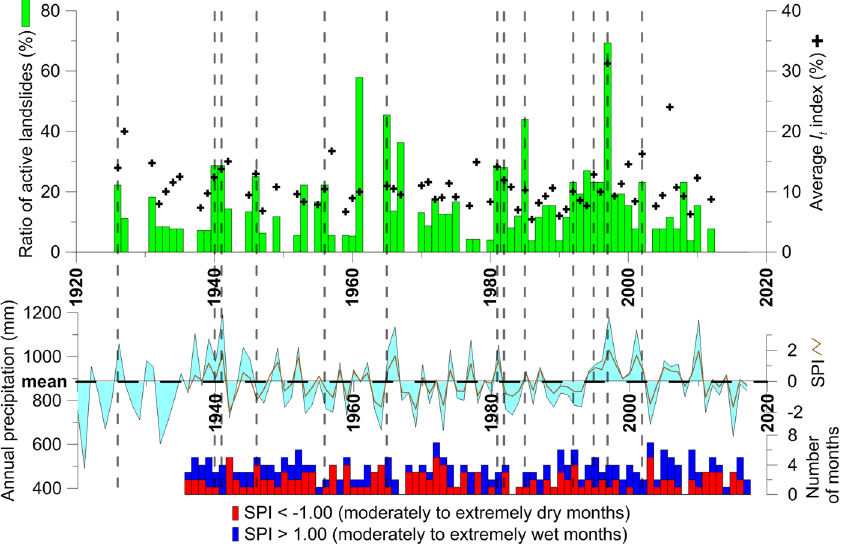
Figure 2. Chronology of landslide activity, annual precipitation totals in the study region, annual Standardized Precipitation Index (SPI) and number of wet/dry months according to the monthly SPI. The ratio of active landslides and value of average I t index (i.e. number of disturbed trees in a particular year divided by the number of all sampled trees living in that particular year; in %) of all landslide events 40 is denoted for each event year. Grey dashed lines show the event years with more than 20% of active landslides and exceeding the 10% value of I t index.